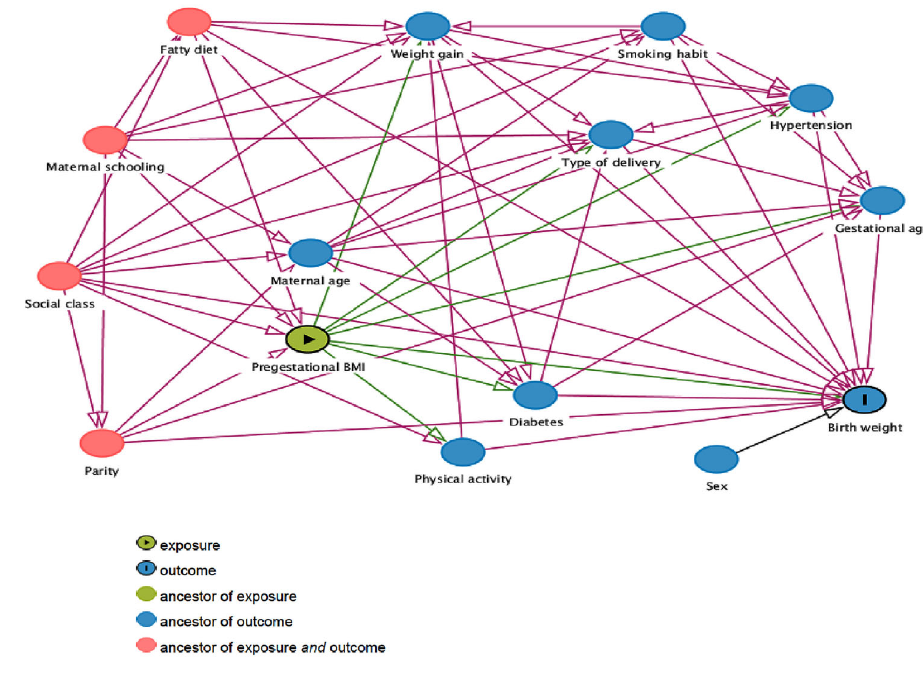
Figure 1. Theoretical model of the association between pre-gestational body mass index (BMI) and birth